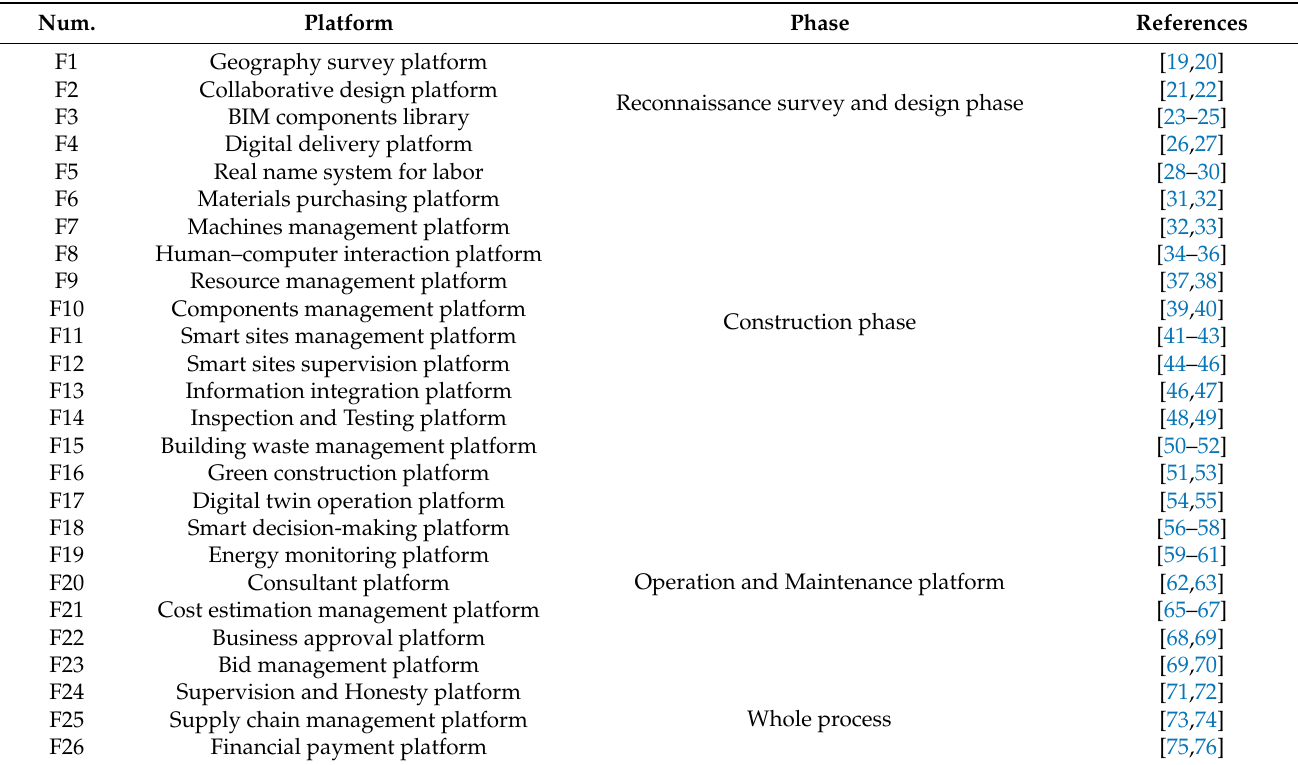
Table 1. Summary of construction industry Internet platform.